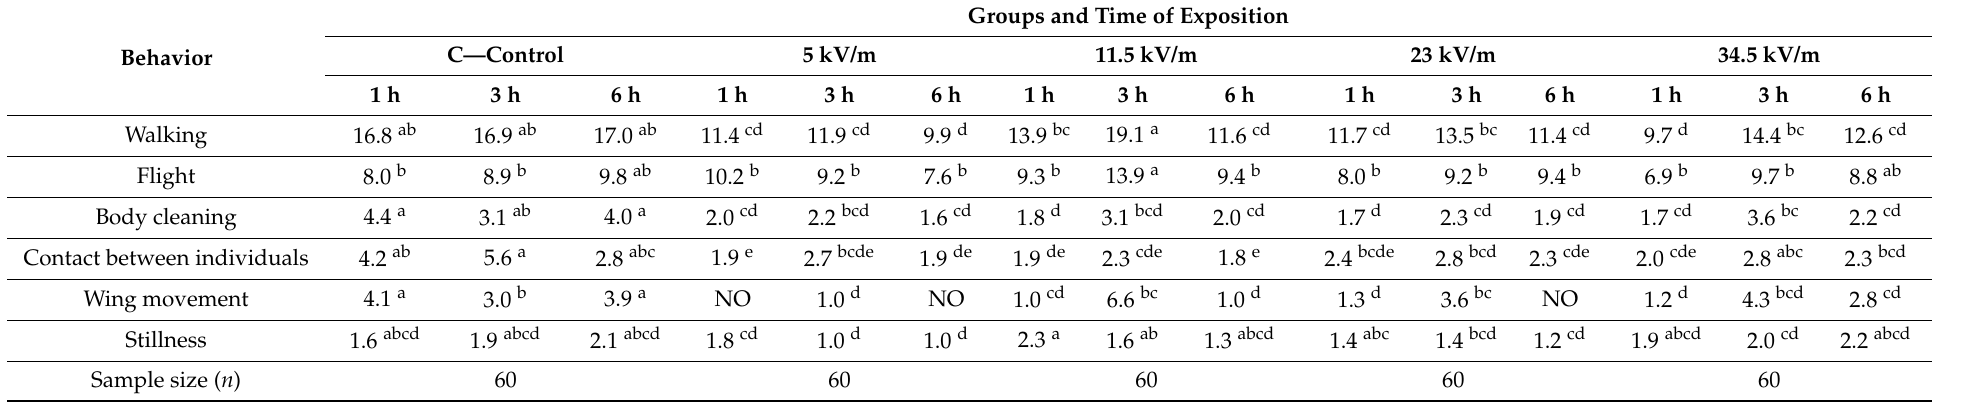
Table 1. Comparison of the mean number of bouts as a function of exposition time and E-field intensity in and between all groups.